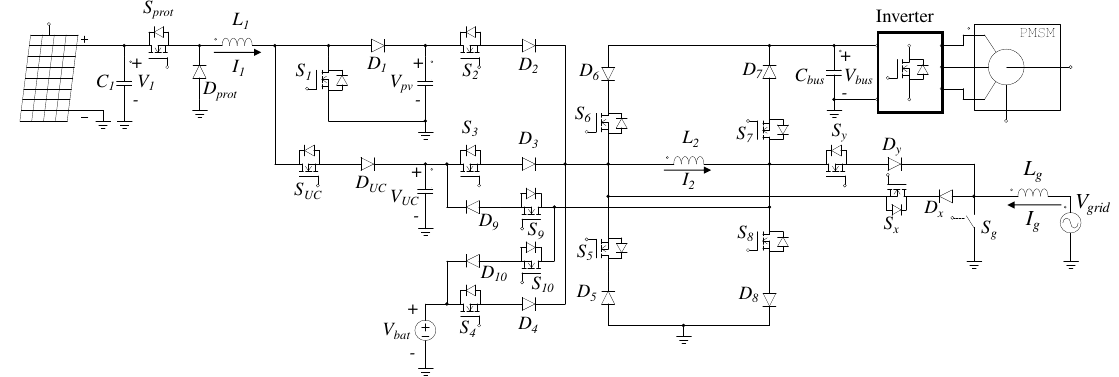
Figure 2. Proposed topology of the power